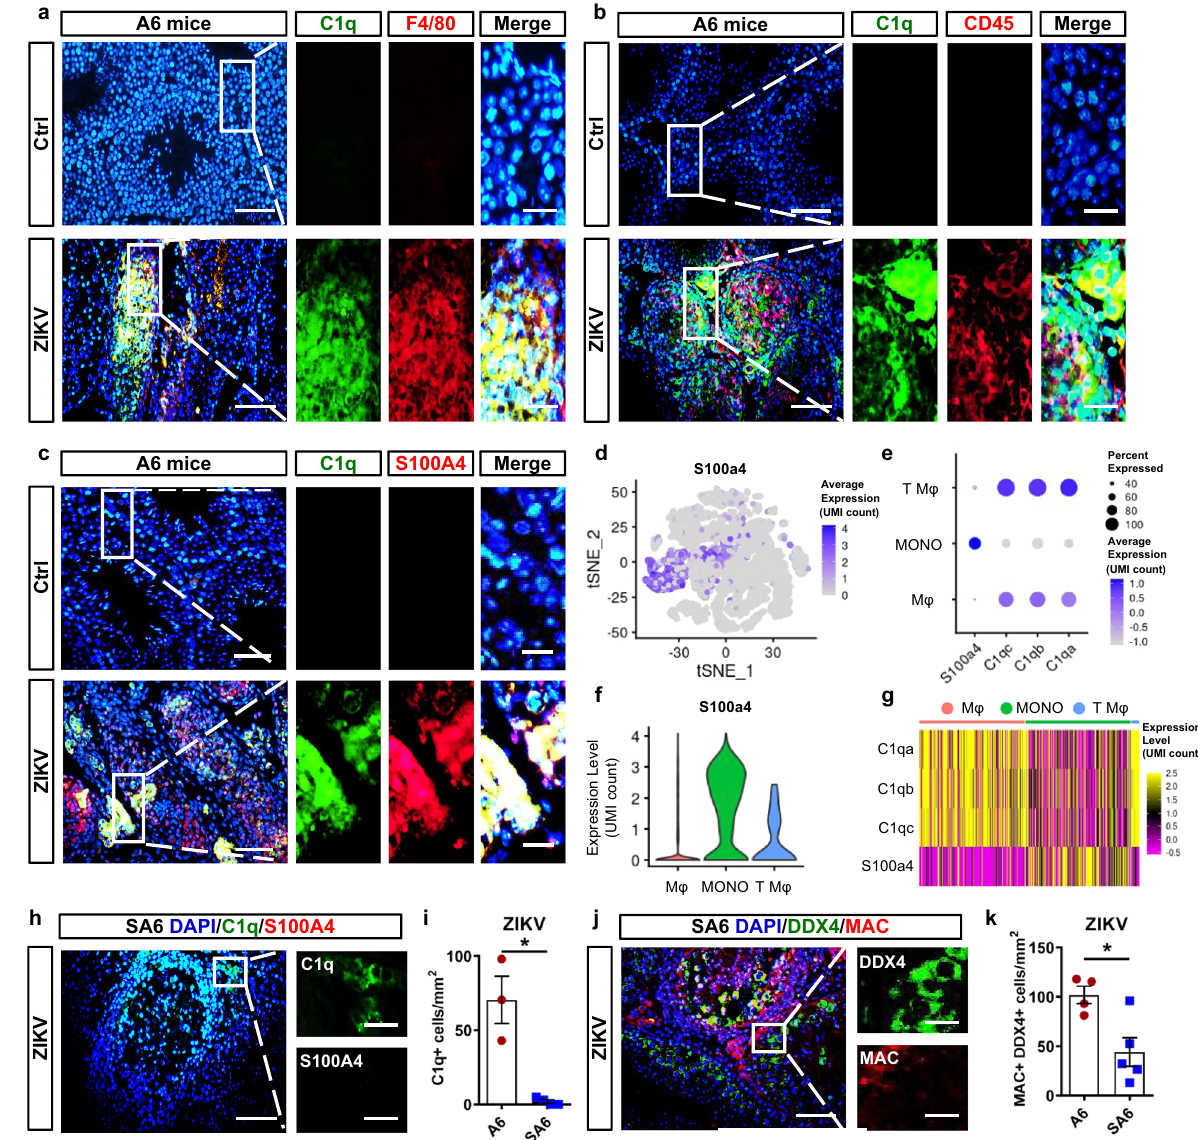
Fig. 5 | C1q was primarily produced by S100A4+monocytes/macrophages. a – c The co-immunostaining of C1q and F4/80 ( a ), C1q and CD45 ( b ), or C1q and S100A4 ( c ) in testes from control or ZIKV-infected A6 mice at 14 dpi. Scale bar, 25 μ m.(10 μ minenlarged panels). d The distribution of S100a4 -expressing cellsin tSNE chart. e The expression level of S100a4 , C1qa , C1qb , C1qc in exogenous macrophages (M φ ), monocytes (MONO), and testicular macrophages (T M φ ) in bubblechart. f , g Theexpressionlevelof S100a4 inexogenousmacrophages(M φ ), monocytes(MONO),andtesticularmacrophages(TM φ )wereshowninviolinchart